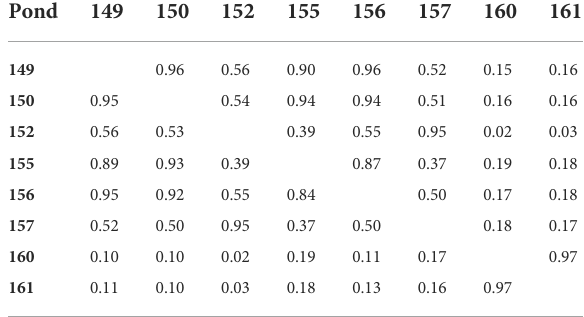
TABLE 1 Shannon-Wiener diversity index of prawn families across ponds. Pond